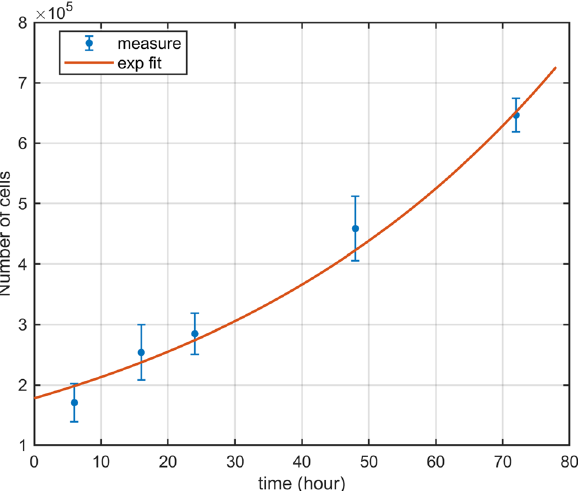
Figure 1. Cell growth curve. Number of unirradiated cells (pre-treatment condition) as a function of time and exponential fit of the